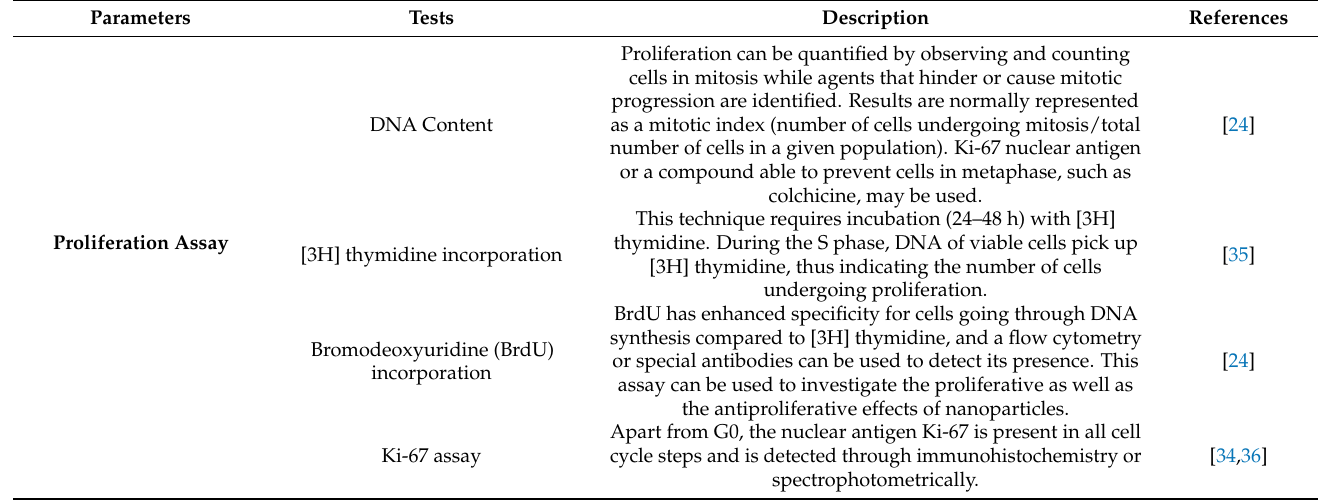
Table 1. In vitro assays for evaluating